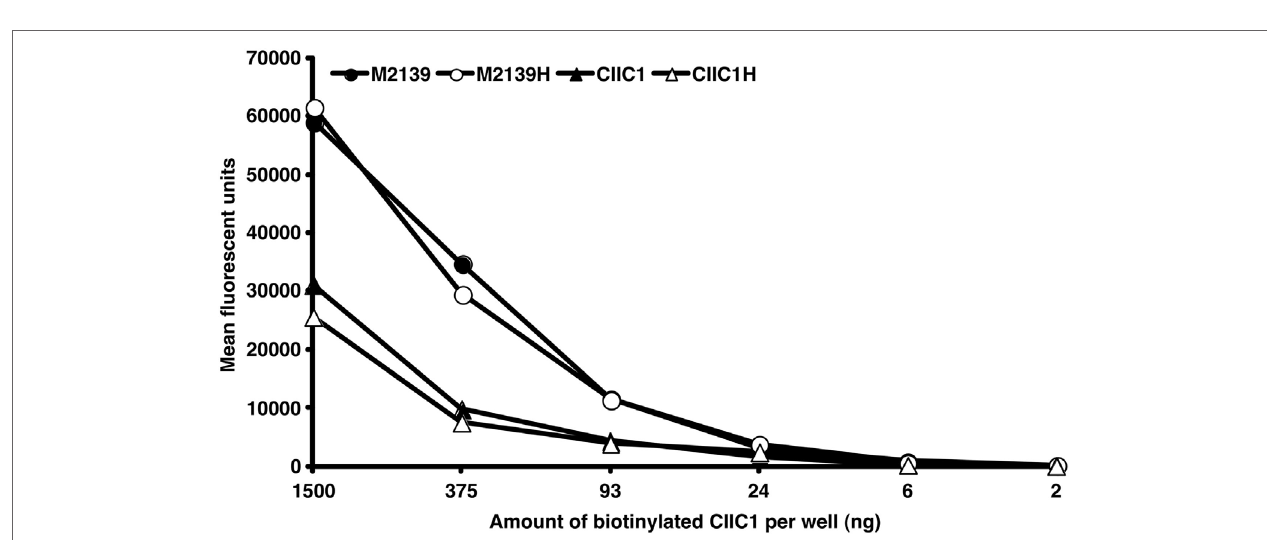
FigUre 7 | Disturbance of stable ICs and complement activation. Collagen type II (CII; 1 mg/ml) and anti-CII mAb CB20 [low affinity; (a) ] or M2139 [high affinity; (B) ] at 1 mg/ml were mixed together at 1:1 ratio and incubated for 30 min at 37°C, followed by addition of anti-hapten IgG, either unhydrolyzed (Hy2.15) or endo- β - N -acetylglucosaminidase (EndoS)-hydrolyzed IgG (Hy2.15H) containing minor amounts of EndoS at the ratio 1:1:1. Twenty microliters of this mixture were loaded on to capillary tube in the Dynamic Light Scattering instrument. Relative sizes of ICs present in the solution are indicated in the X-axis and Y-axis denotes percentage of ICs present in the solution. Each sample was measured 5–7 times and the bars represent mean values from two experiments. Error bars indicate ± SEM. (c) Complement activation on CII bound anti-CII antibodies (M2139H) were monitored by measuring C3b deposition. Each bar represents mean values from three experiments ± SD. (D) Deposition of C3b on the cartilage of mice was used as a measure of IC deposition and complement activation after the injection of EndoS-hydrolyzed containing minor amounts of EndoS, unhydrolyzed or mixed anti-CII IgG. Two- to three-day-old mouse pups (3–4 mice/group) were injected with 1 mg each of unhydrolyzed IgG (M2139 + CIIC2 + UL1), EndoS-hydrolyzed IgG (M2139H + CIIC2H + UL1H) containing minor amounts of EndoS or a mixture of IgGs at 1:1 ratio. In each group, 26–44 joints were scored in total. ** p < 0.01; *** p < 0.005. Error bars indicate ± SEM. (e) Paw samples collected 24 h later were stained with biotinylated anti-kappa (left column) or goat anti-mouse anti-C3c antibodies (right column). Joint sections from PBS (first row), unhydrolyzed (second row), EndoS-hydrolyzed containing minor amounts of EndoS (third row), or a mixture (1:1) of IgG (fourth row) injected mice is shown. Magnification 20 × . Arrows indicate C3b deposition within ICs formed on the joint cartilage surface. (F) Diagram illustrating possible binding mechanisms involved in the suppression of arthritis by EndoS-hydrolyzed antibodies containing minor amounts of